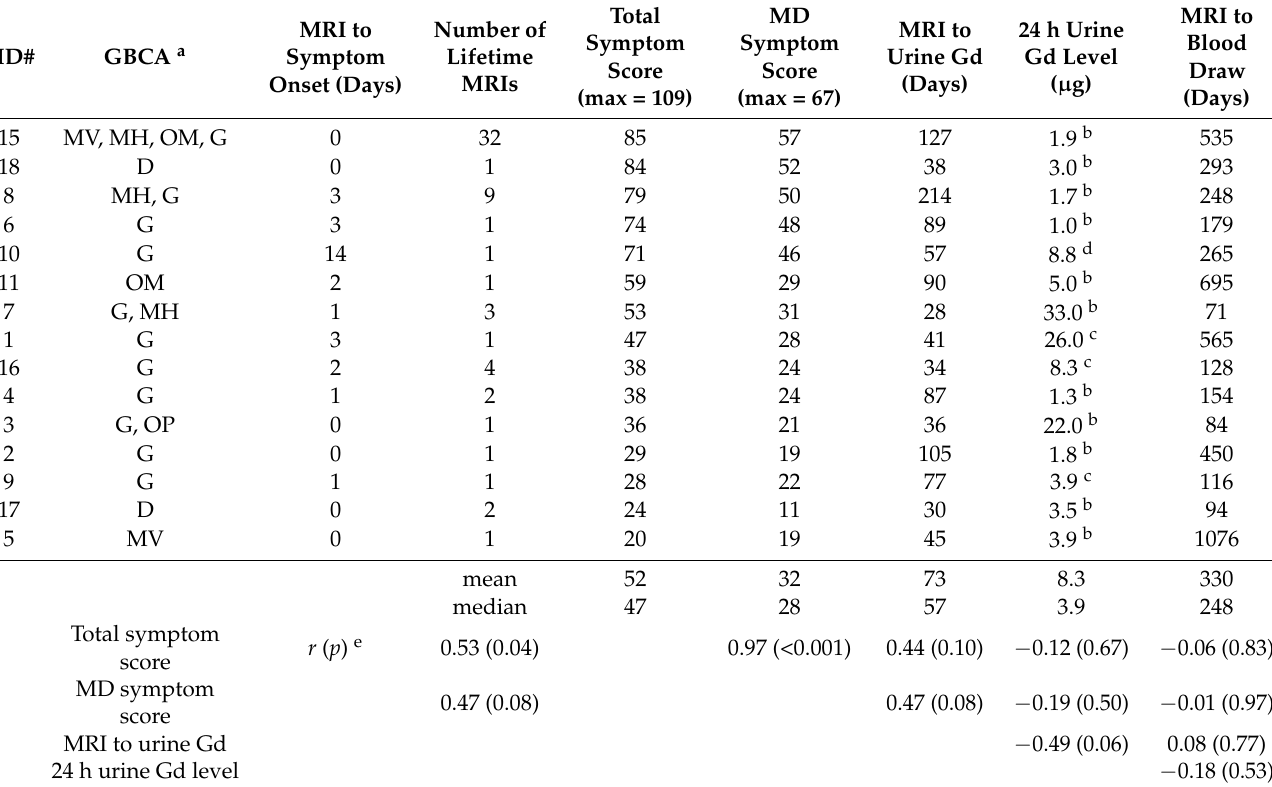
a Linear: MH—gadobenate dimeglumine/MultiHance ® ; MV—gadopentetate dimeglumine/Magnevist ® ; OM—gadodiamide/Omniscan ® ; OP—gadoversetamide/OptiMARK ® ). All others are macrocyclic: (G— gadobutrol/Gadovist ® ; D—gadoterate/Doterem ® ). Unprovoked limits: b Mayo Clinic Laboratory ≤ 0.4 µ g/24 h;